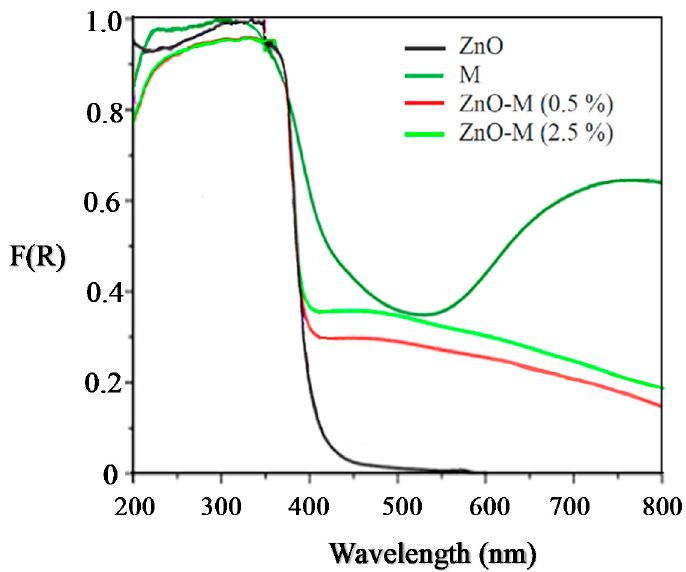
Figure 1. UV-Vis DR spectra for the ZnO/Ag 3 PO 4 ( up ) and ZnO-M ( down ) composites. XRD patterns of the different samples are depicted in Figure 2. For the ZnO/Ag 3 PO 4 composites (Figure 2a), the characteristic peaks for Ag 3 PO 4 and ZnO can be observed with a cubic phase and Wurtzite structure, respectively. The increase in Ag 3 PO 4 content leads to a gradual increase in the intensity of the signal (200) corresponding to phosphate, while the intensity of the signals for ZnO decreases.